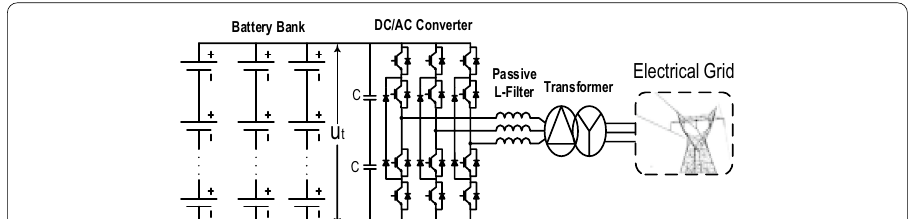
Fig. 2 Typical structure of BES interfaced to the transmission power grid